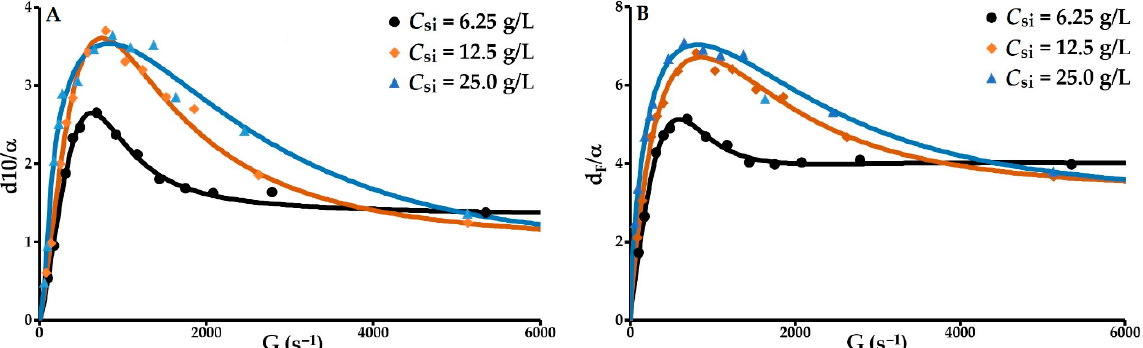
Figure 5. Relative ratio of floc quartile diameter d10. ( A ) and mean floc diameter d F ; ( B ) to Kolmogorov microscale as a function of the velocity gradient.